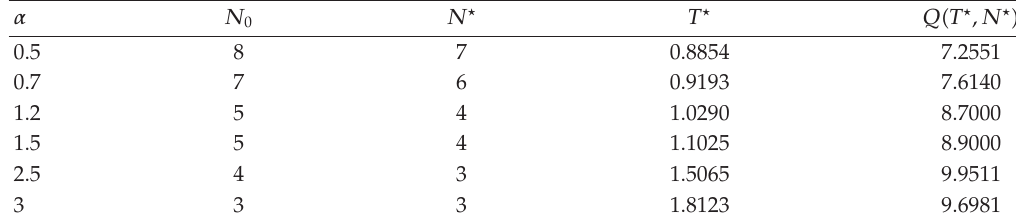
Table 3: N (cid:4) , T (cid:4) , Q (cid:6) T (cid:4) , N (cid:4) (cid:7) . Costs: c pr (cid:5)